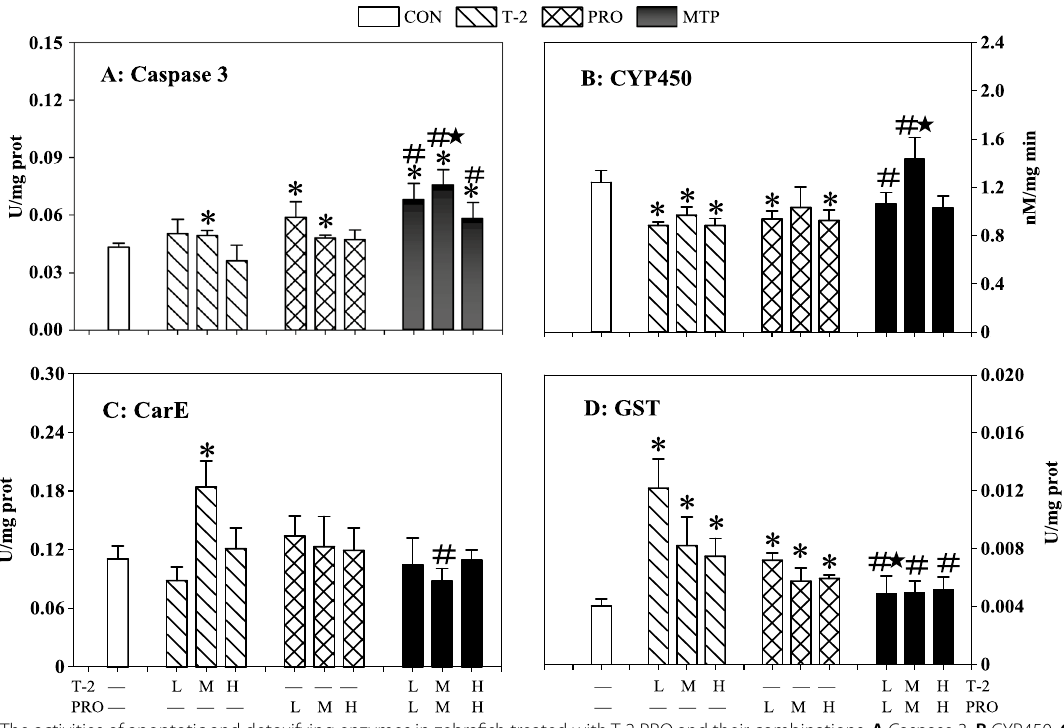
Fig. 2 The activities of apoptotic and detoxifying enzymes in zebrafish treated with T-2 PRO and their combinations. A Caspase 3, B CYP450, C CarE, D GST. Each bar represents the mean standard deviation ( n three replicates consisting of a group of 250 fish). * p < 0.05 substantial alteration ± = by comparison with the control; # p < 0.05 significant difference relative to the corresponding T-2 exposure; ★ p < 0.05 significant difference relative to the corresponding PRO exposure. CON control, T-2 T-2 toxin, PRO propiconazole, MTP the mixture of T-2 and PRO. L low concentration, M middle